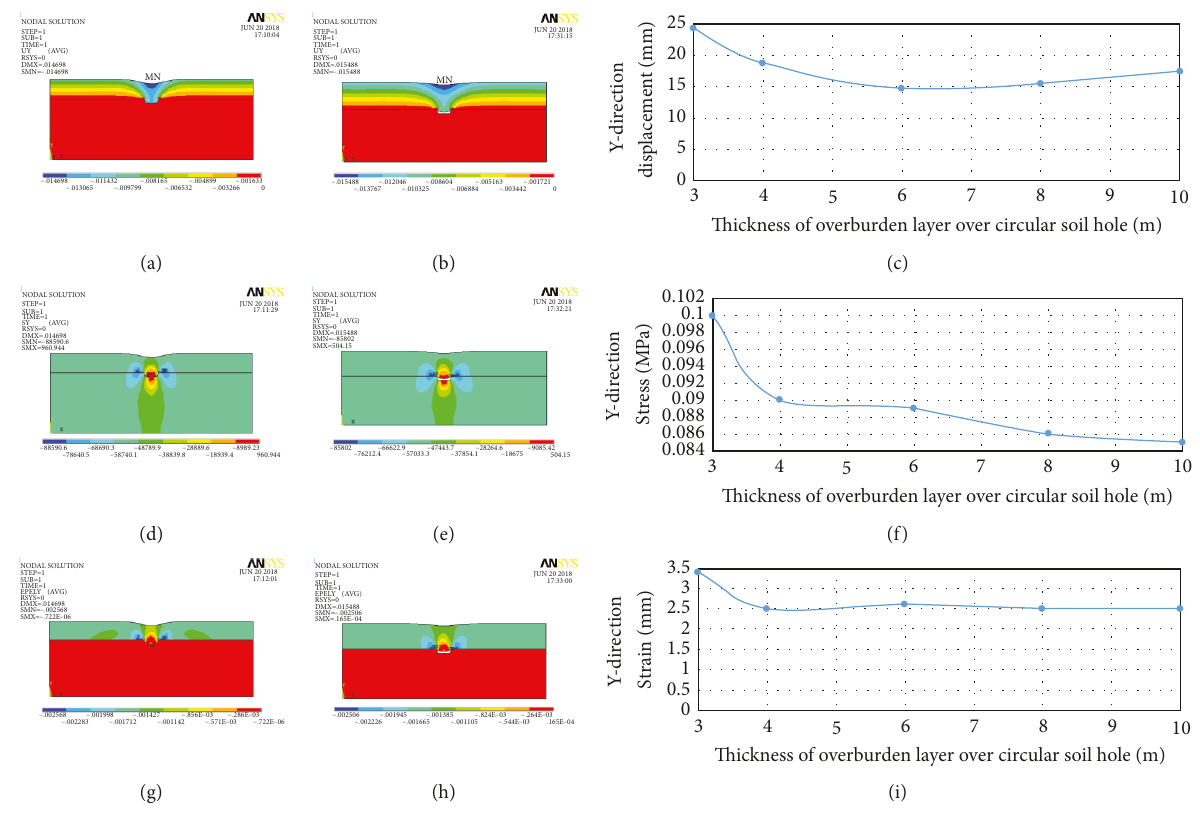
Figure 11: q � 50.89kPa scenario. Results of displacement cloud map: (a) H � 6m and (b) H � 10m; (c) displacement curve; stress cloud map: (d) H � 6 m and (e) H � 10m; (f) stress curve; strain cloud map: (g) H � 6 m and (h) H � 10m; (i) strain